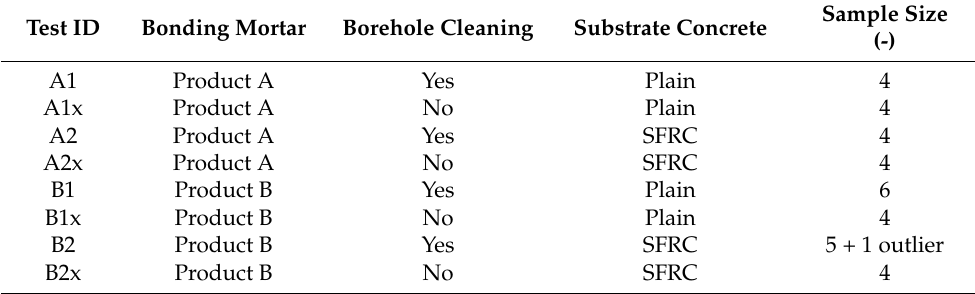
Figure 4. Concreting ( a ) and test arrangements ( b ). Table 1. Overview of pull-out tests.